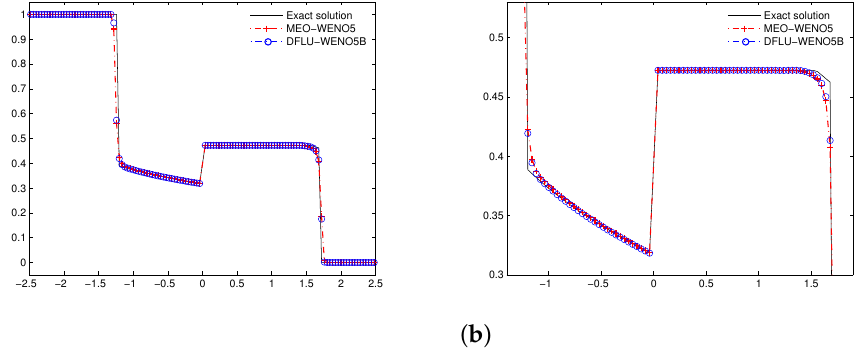
Figure 13. Example 3 computed by the MEO-WENO5 and DFLU-WENO5B with ∆ x = 1/25. ( a ): the numerical and exact solutions; ( b ): the numerical and exact solutions zoomed